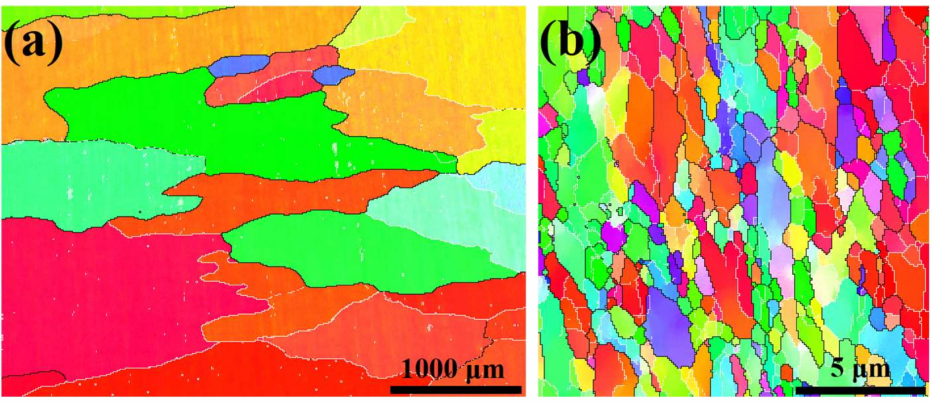
Figure 8. Electron backscattered di ff raction (EBSD) inverse pole figure (IPF) mapping of the substrate sample: ( a ) cast sample and ( b ) ECAPed